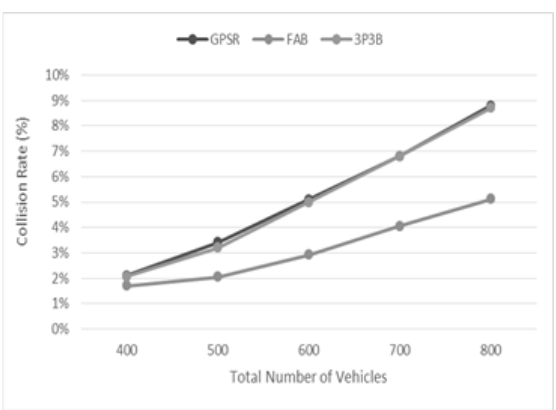
Fig. 6. The collision rates of FAB, GPSR, and 3P3B with various vehicle numbers.